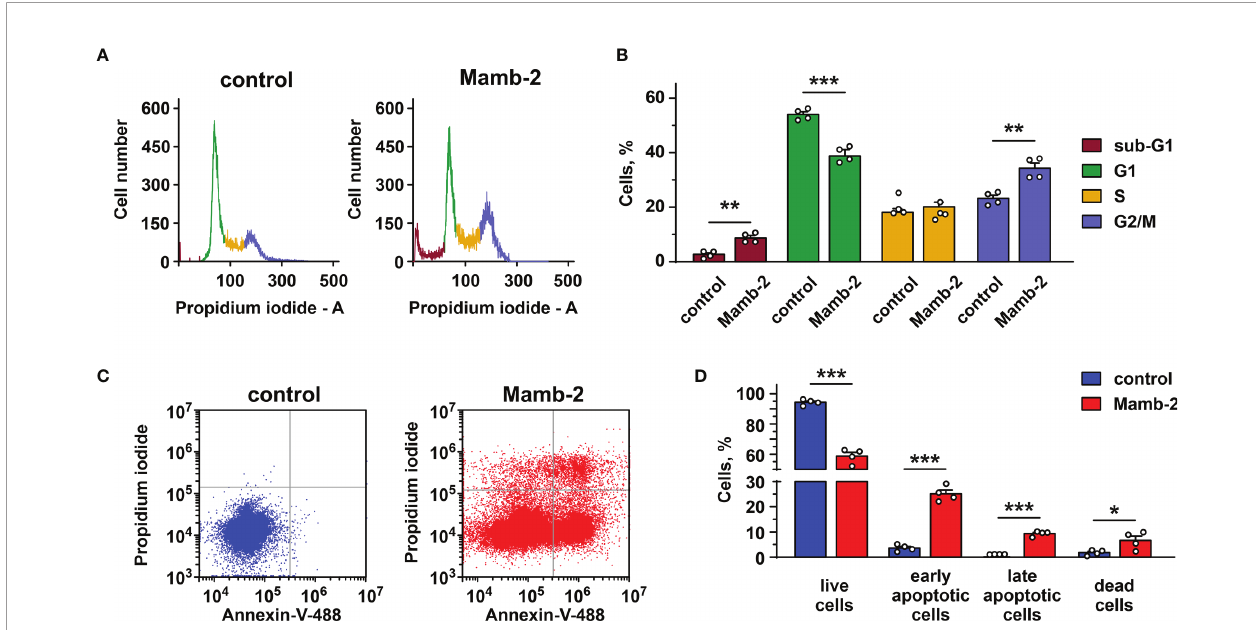
FIGURE 3 | Analysis of cell cycle and apoptosis induction by mambalgin-2 in A549 cells. (A) Representative nucleus population distribution of A549 cells incubated in the absence (control) or presence of 1 µM mambalgin-2. (B) % of cells in each cell cycle phase. Data are presented as % of cells in each cell cycle phase ± SEM (n = 4). ** (p < 0.01) and *** (p < 0.001) indicate signi fi cant difference between the data groups by two-tailed t-test. (C) Representative pictures of phosphatidylserine externalization analysis upon the 1 µM mambalgin-2 treatment of A549 cells by fl ow cytometry with Annexin V-488 and propidium iodide (control is in absence of mambalgin-2). (D) Percentage of A549 cells with externalized phosphatidylserine and bound propidium iodide in the absence (control) or presence of 1 µM mambalgin-2. The data are presented as % of live, early apoptotic, late apoptotic, and dead cells ± SEM (n = 4). * (p < 0.05) and *** (p < 0.001) indicate the signi fi cant difference between data groups by a two-tailed